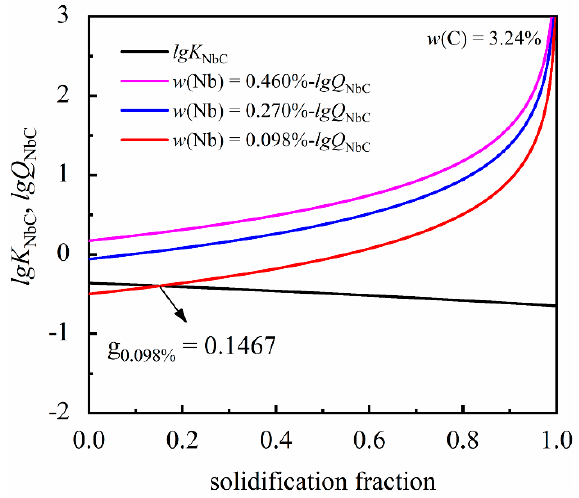
Figure 2. The variations of actual concentration product and equilibrium solubility product during